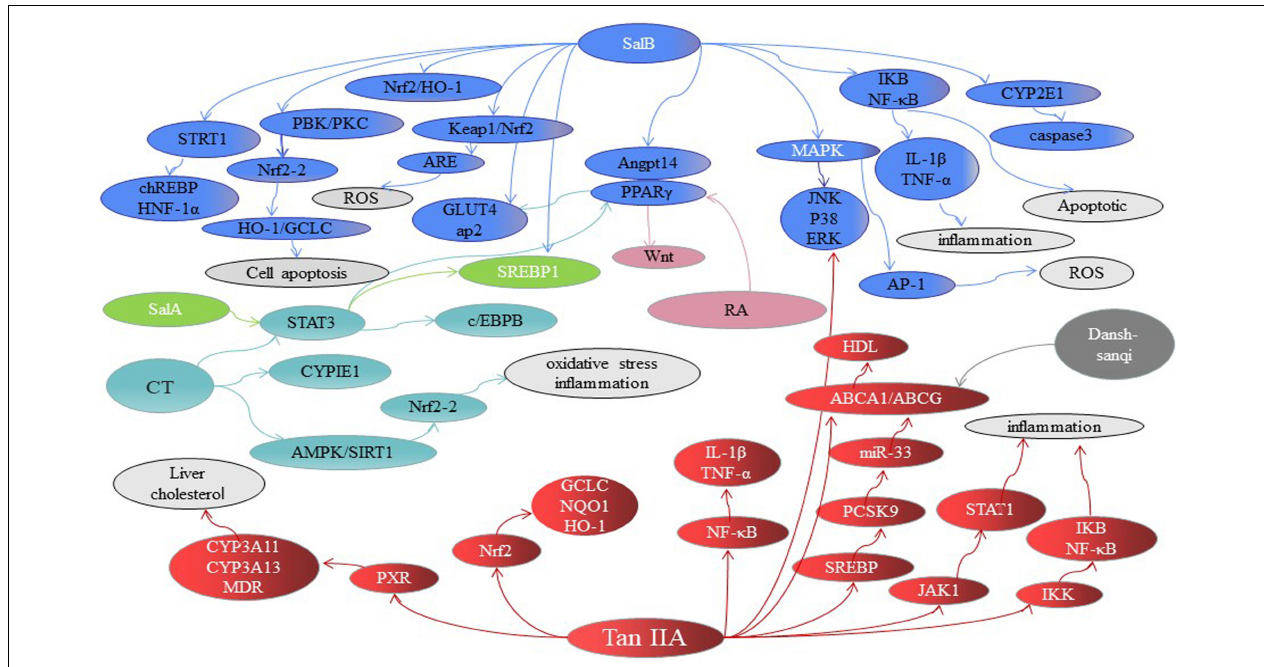
FIGURE 4 | The major signaling pathways involved in treating NAFLD of Danshen compounds. SAB, Salvianolic acid B; SAA, Salvianolic acid A; SAC, Salvianolic acid C; RA, Rosmarinic acid; TSIIA, tanshinone IIA; CT, Cryptotanshinone. FA, fatty